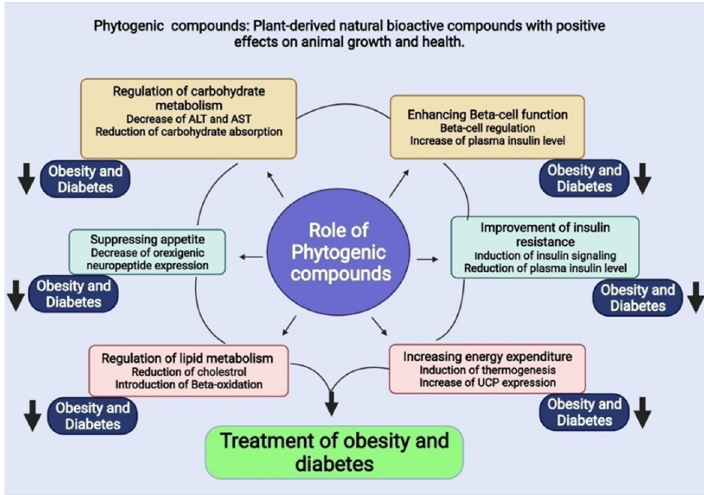
Figure 3. Phytogenic chemicals and diabetes. Phytogenic substances as possible options for obesity and diabetes therapies are shown.